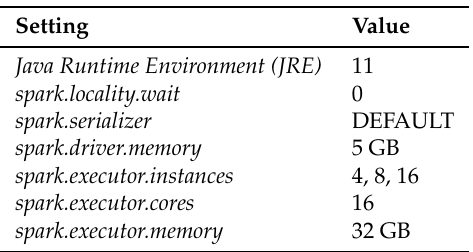
Table A1. Relevant Spark configuration settings.